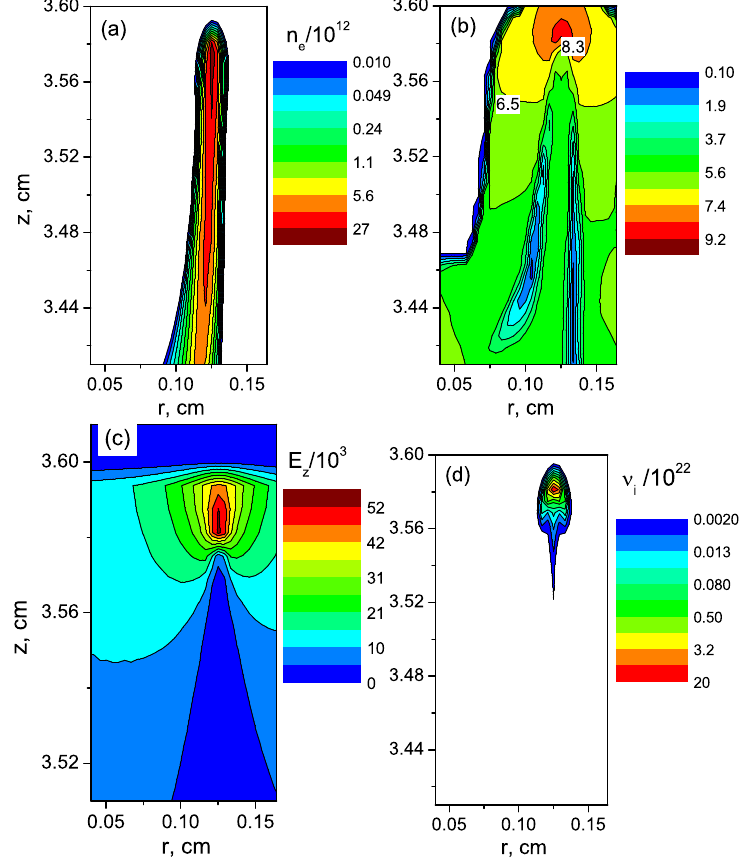
Figure 11. Spatial distributions of electron density, color palette is for (10 10 –2.7 × 10 13 ) cm − 3 , log scale ( a ), electron energy, color palette, (0.1–9.2) eV ( b ), normal component of electric field E z , color palette, (5.2 × 10 3 –5.2 × 10 4 ), V/cm ( c ) and ionization rate ν i , color palette, (10 19 –2 × 10 23 ) cm − 3 s − 1 , log scale ( d ), with the GR